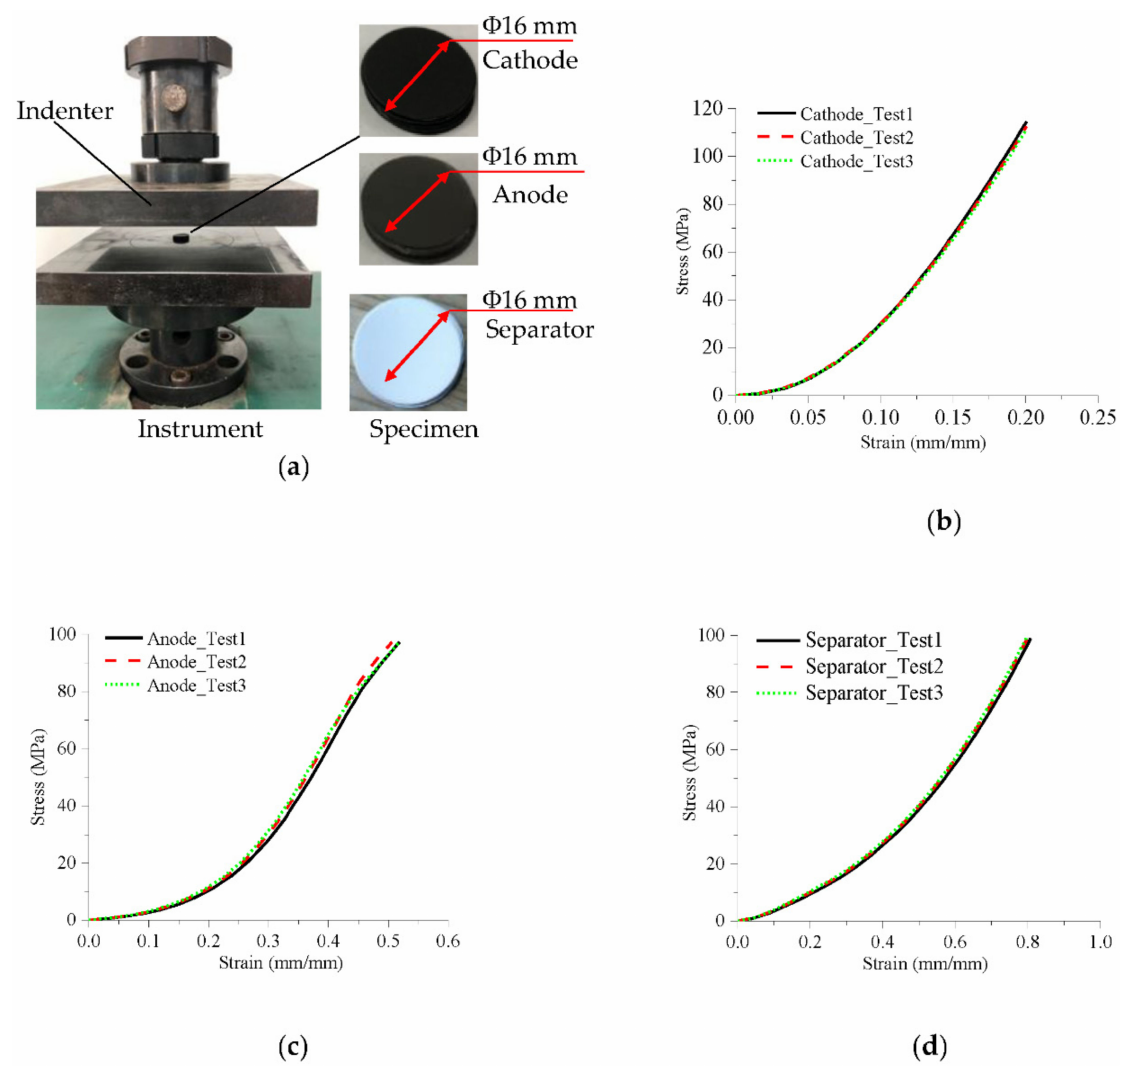
Figure 3. Compressive test of component materials for prismatic cell: ( a ) Test setup and specimens of tested component materials; ( b ) Compressive stress-strain curves for cathode specimen; ( c ) Compressive stress-strain curves for anode specimen; ( d ) Compressive stress-strain curves for separator